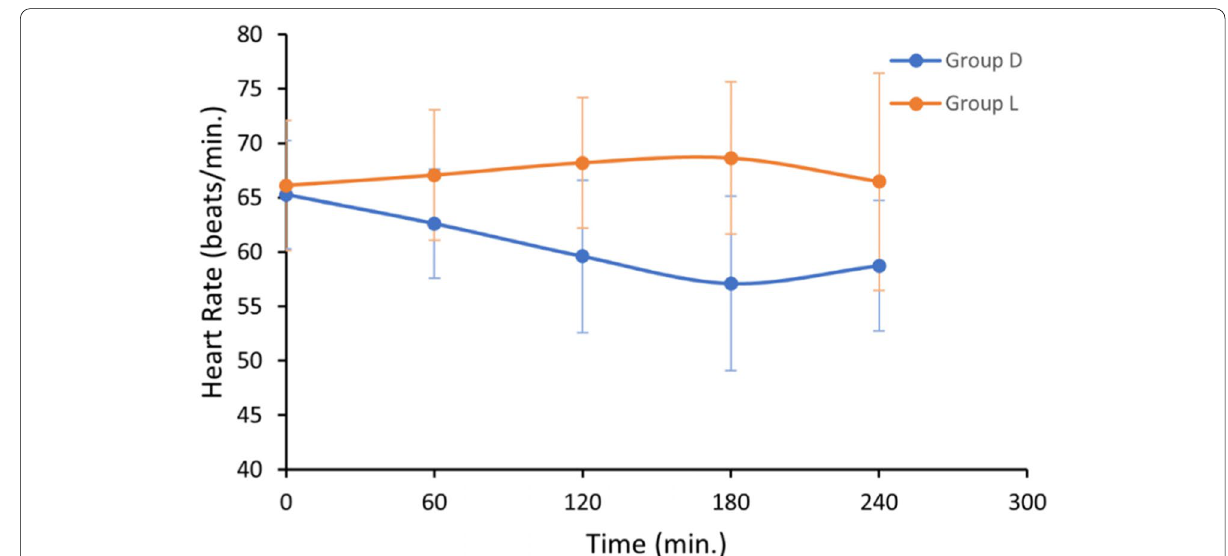
Fig. 1 Comparison of intraoperative heart rate for the two